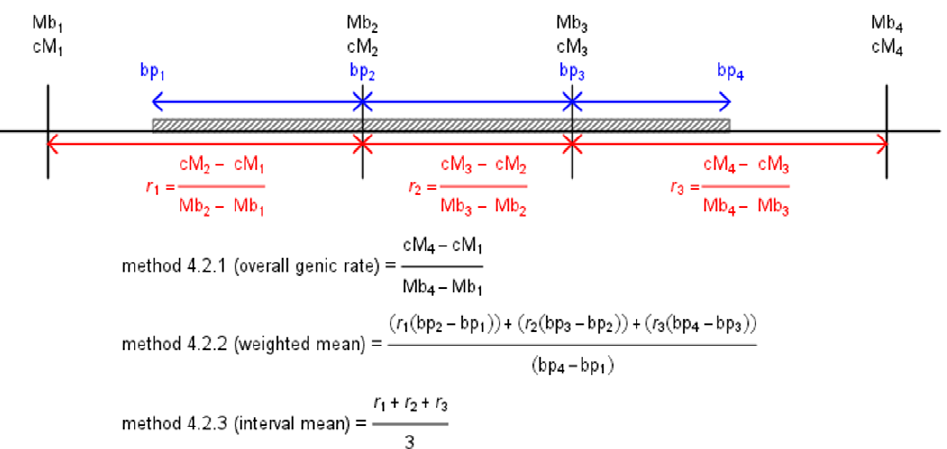
Figure 1. Methodologies used to generate gene-focused recombination rates. Representation of the methods used to calculate gene- focused recombination rates (methods 4.2.1, 4.2.2 and 4.2.3). Note that this diagram is for descriptive purposes only and is not to scale. For simplicity, only calculations for mean rates are shown. The grey region is a gene. Vertical black lines represent four SNP markers with physical (Mb) and genetic (cM) positions. Blue arrows represent the base pairs of the gene overlapping with each intervening SNP interval. In red are recombination rates ( r x ) between pairs of neighbouring markers.